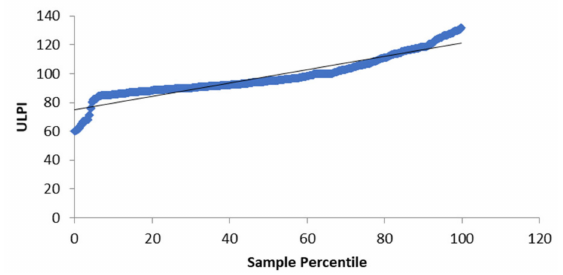
Figure A1. Normality probability plot for regression model (2).